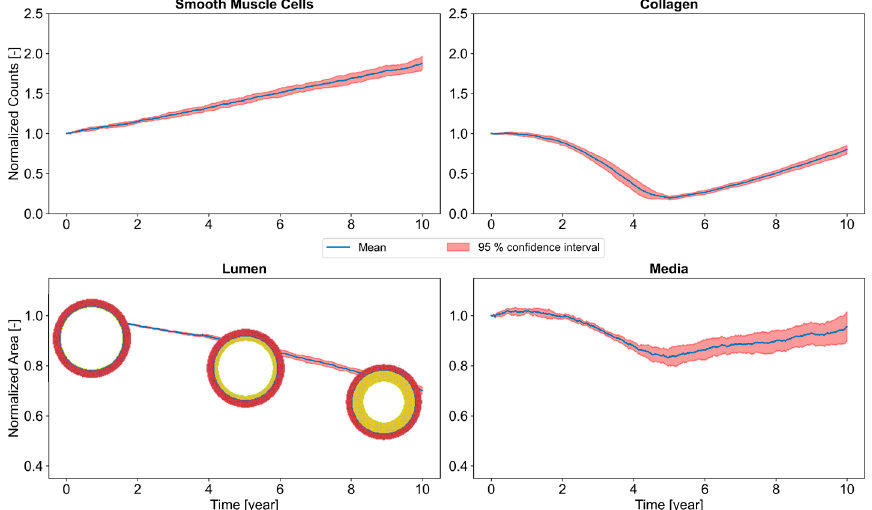
Figure 15. The number of smooth muscle cells (SMCs) and quantity of collagen, normalized surfaces or arterial lumen, and the media for exposure to vibrations for 4 h a day as a function of years’ exposure. The geometry of the artery is given in the initial state and at the end of 5 and 10 years of exposure.